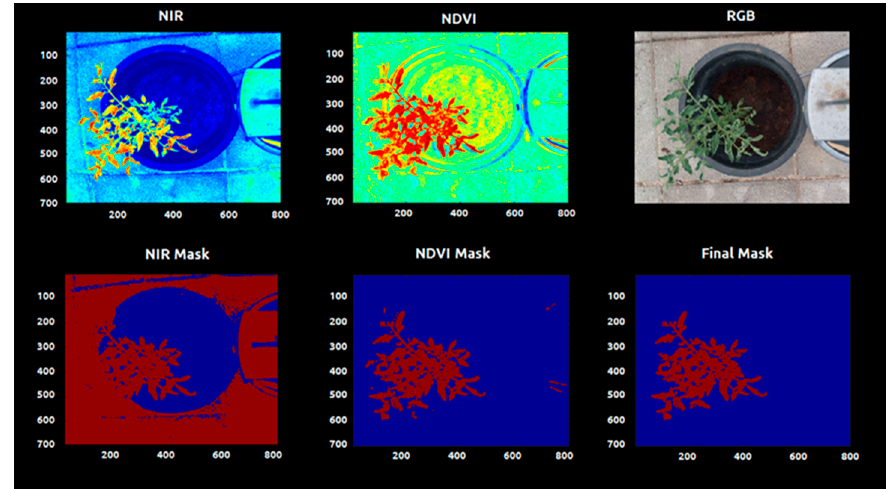
Figure 5. Computer vision process based in NDVI image used to extract the plant from the background. Top images: Near-infrared (left), NDVI (center), and RGB (right); bottom images: binarized images.